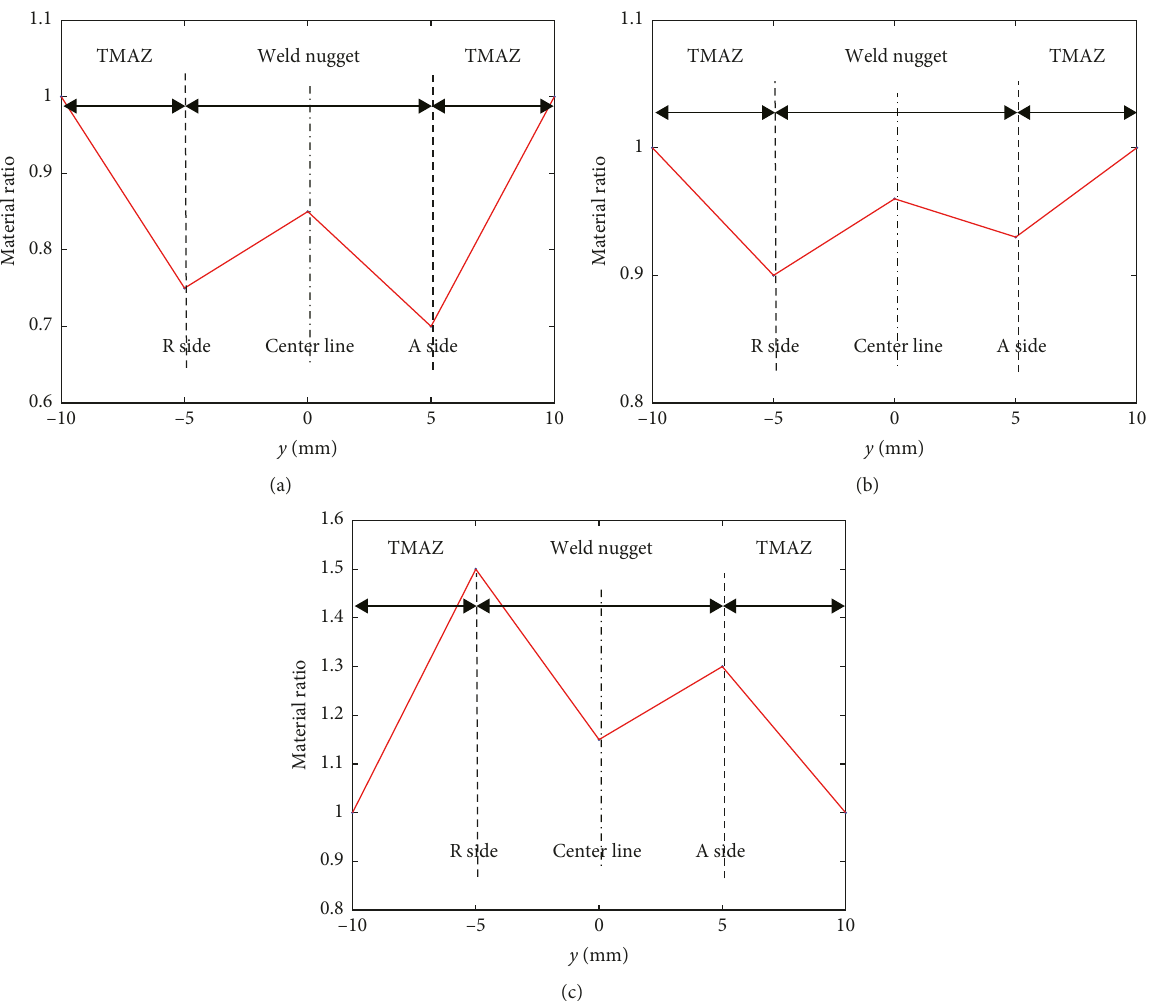
c , s Y and s 0 , (b) m 2 , (c) A 2